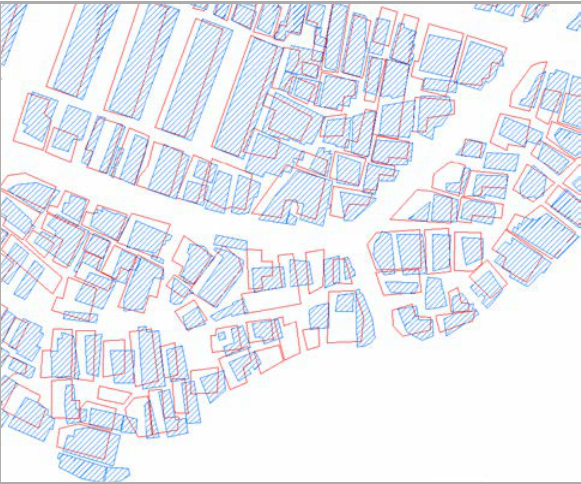
Figure 1. Test datasets(Red: Digital topographic map, Blue: KAIS map) Firstly, 32 polygon pairs which is the same building name among polygons intersected in two geospatial datasets were randomly extracted (Figure 2). The extracted polygons were transformed into centroids, and then two datasets were aligned by similarity transformation by using these